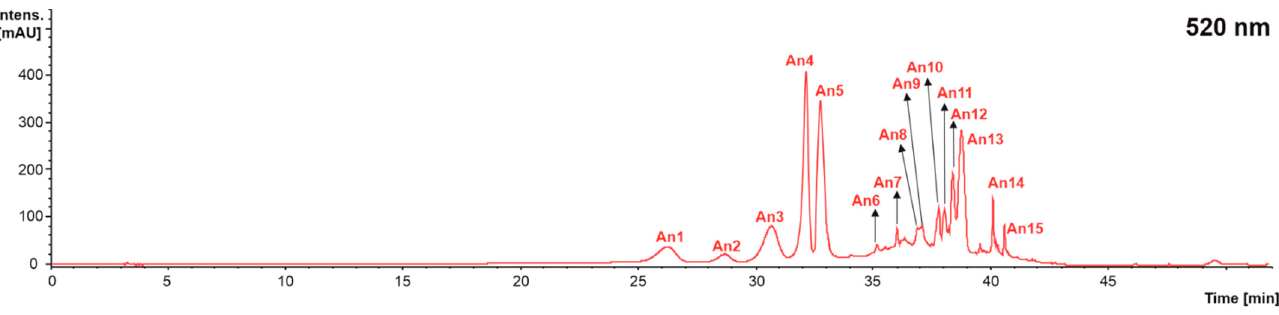
Figure 5. Chromatogram recorded at 520 nm representative of the anthocyanins (An) recorded in grape stems, grape pomace, and wine lees. Identification of the peaks annotated according to Table 5. Table 5. Identification of anthocyanins in grape ( Vitis vinifera L. var. ’Monastrell’) stem and pomace, as well as wine lees by HPLC-PDA-ESI-MSn operating in positive